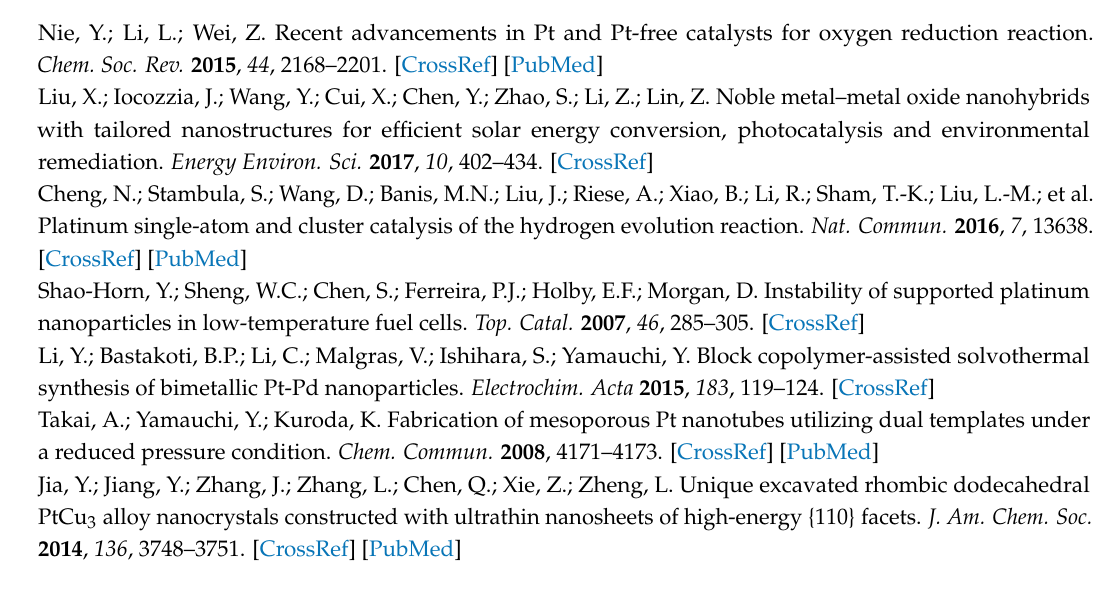
Figure S1. SEM images of mesoporous Pt samples prepared with molar ratios of PtCl 62 − /P2VP: (a) 1.5:1 and (b) 5:1., Figure S2. TG data of polymeric micelle of PS 192 - b -P2VP 143 - b -PEO 613 , Figure S3. SEM images of mesoporous Pt samples (a) Pt-0, (b) Pt-250 and (c) Pt-450, Figure S4. SEM image of commercially available Pt black. Figure S5. (a,b) Cyclic voltammograms detected in 0.5 M H 2 SO 4 containing 0.5 M CH 3 OH solution with the potential between 0 and 1 V at a scan rate of 50 mV · s − 1 . The currents of panel (a) were normalized by the Pt mass and the currents of panel (b) were normalized by the ECSA values obtained from the CV curves recorded in 0.5 M H 2 SO 4